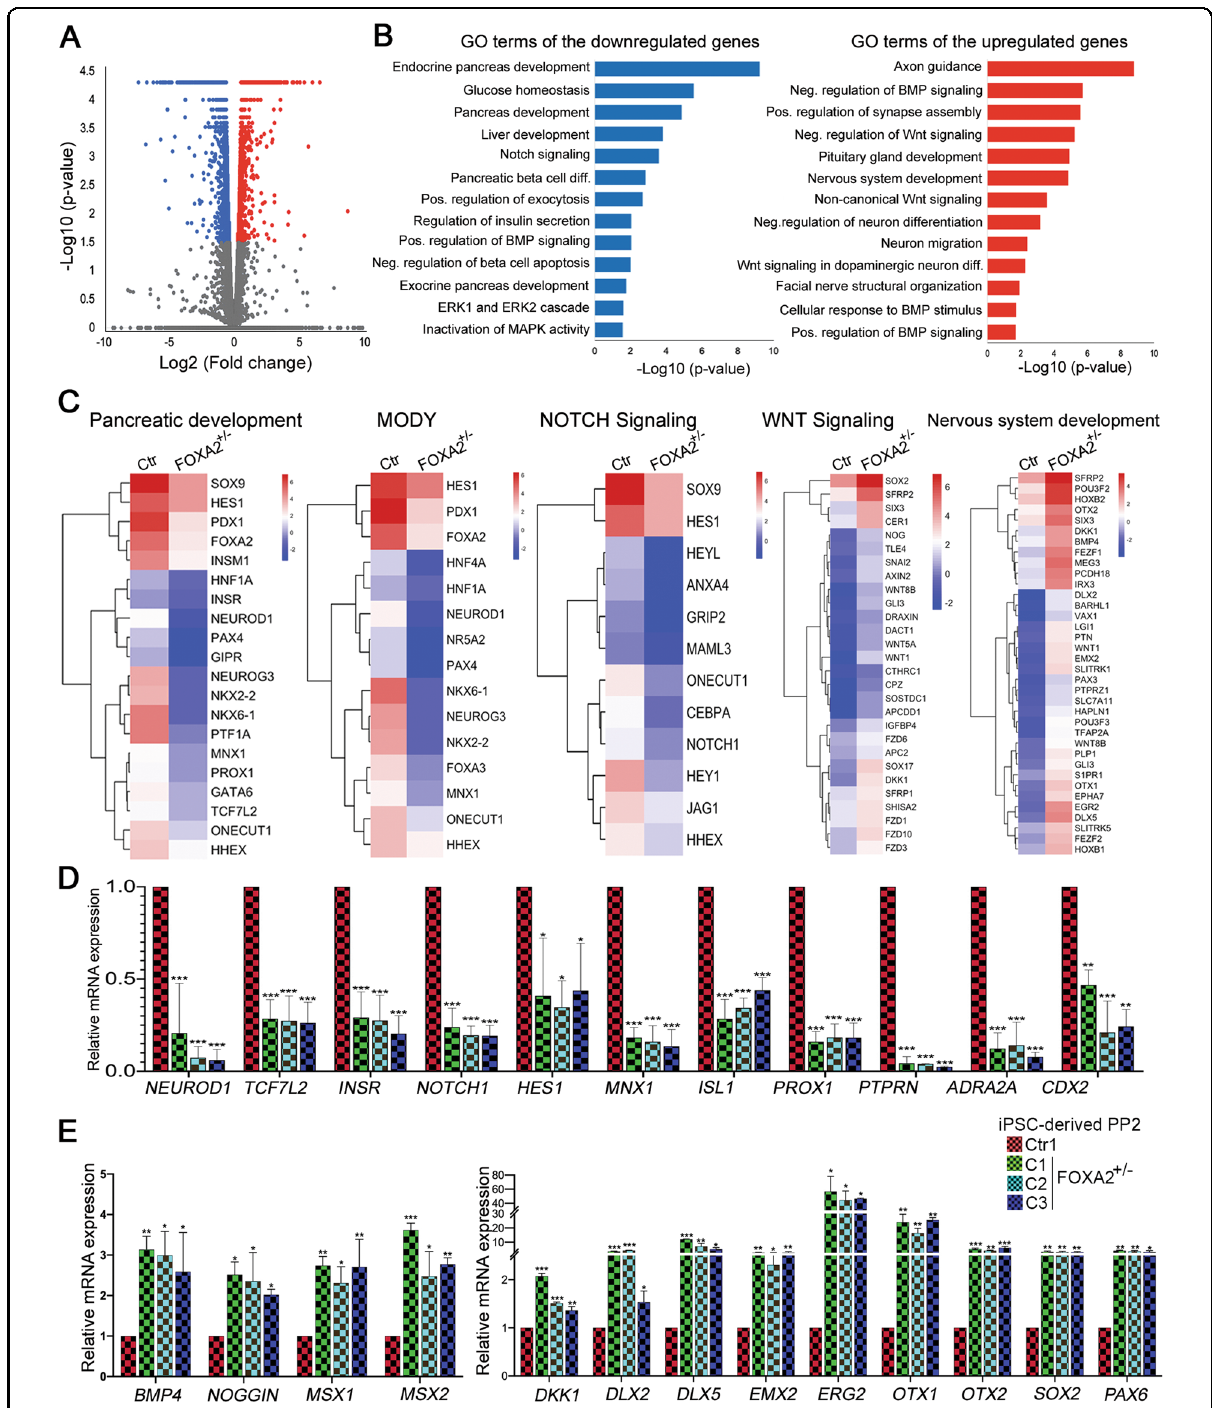
Fig. 4 Transcriptomic alterations in pancreatic progenitors (PP2) derived from FOXA2 + / − iPSCs. A Volcano plot plotting the log2 fold change (FC) and the adjusted p -value for all the transcripts. B Pathway enrichment analysis on the upregulated and downregulated differentially expressed genes (DEGs) in FOXA2 + / − iPSC-derived pancreatic progenitors (PP2) using the DAVID function annotation tool. The enriched pathways were plotted against − log10 ( p -value). C Heatmaps of pathway-associated DEGs in PP2 derived from FOXA2 + / − iPSCs compared to those derived from Ctr-iPSCs. The downregulated genes were associated with pancreatic development, maturity-onset diabetes of the young (MODY), and NOTCH signaling pathways, while the upregulated genes were associated with the WNT signaling pathway and nervous system development. The relative value for each gene is depicted by color intensity, with red indicating upregulated and blue indicating downregulated genes. RNA-Seq results were validated using qPCR for the downregulated ( D ) and the upregulated genes ( E ). Data are represented as mean ± SD; * p < 0.05, ** p < 0.01, *** p < 0.001.